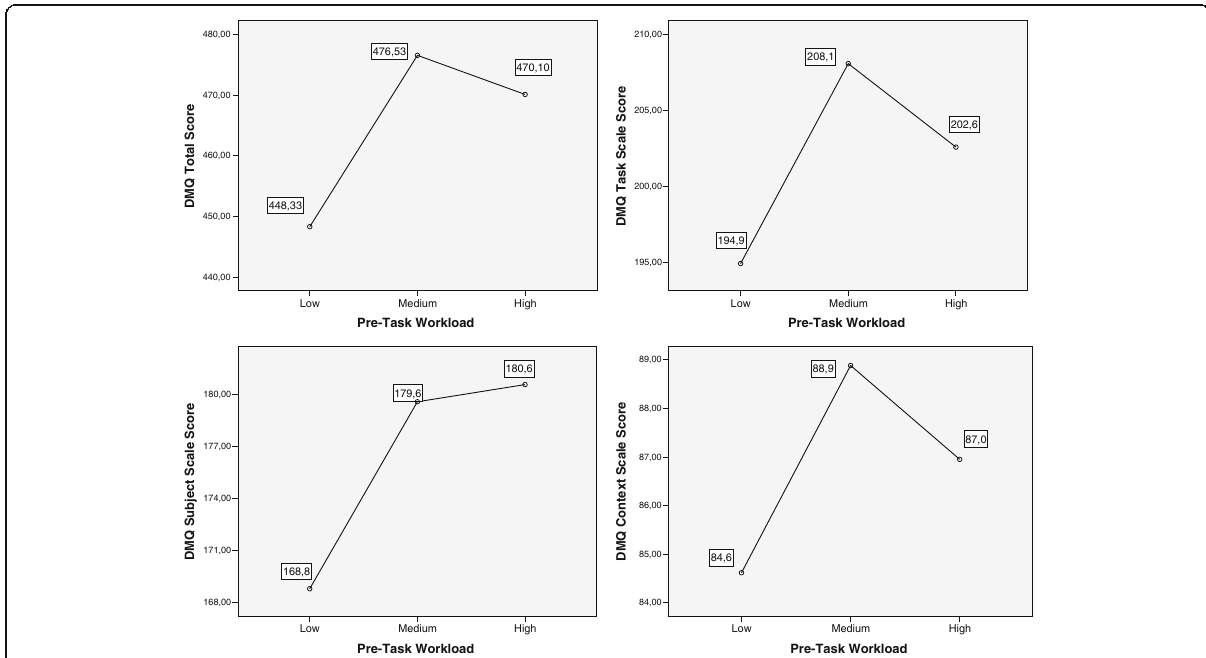
Fig. 2 Estimated marginal means. DMQ-Global scale, DMQ-Task subscale, DMQ-Subject subscale, and DMQ-Context subscale vs. Pre-Task Workload. DMQ Decision-Making